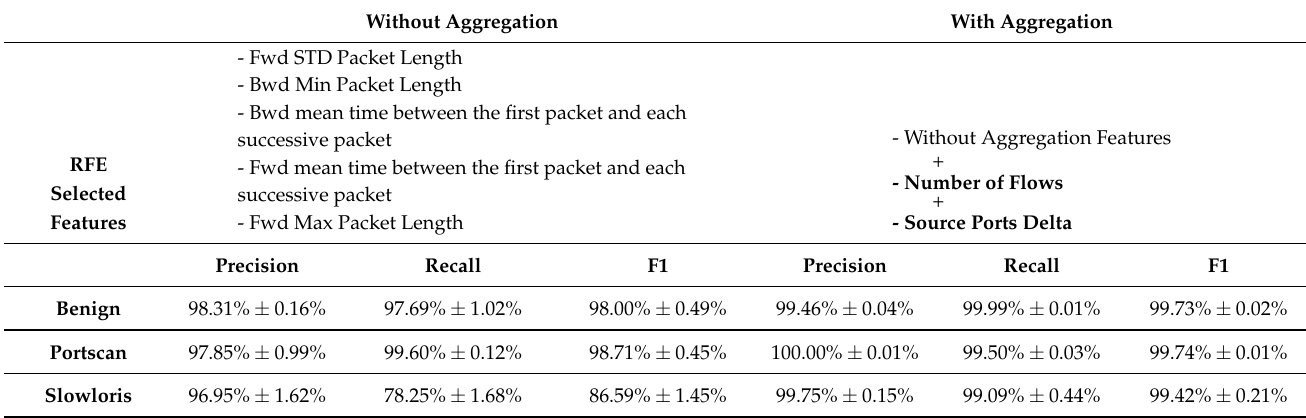
Table 8. Benign vs. PortScan vs. Slowloris classification (5-fold cross validation). Without Aggregation With Aggregation